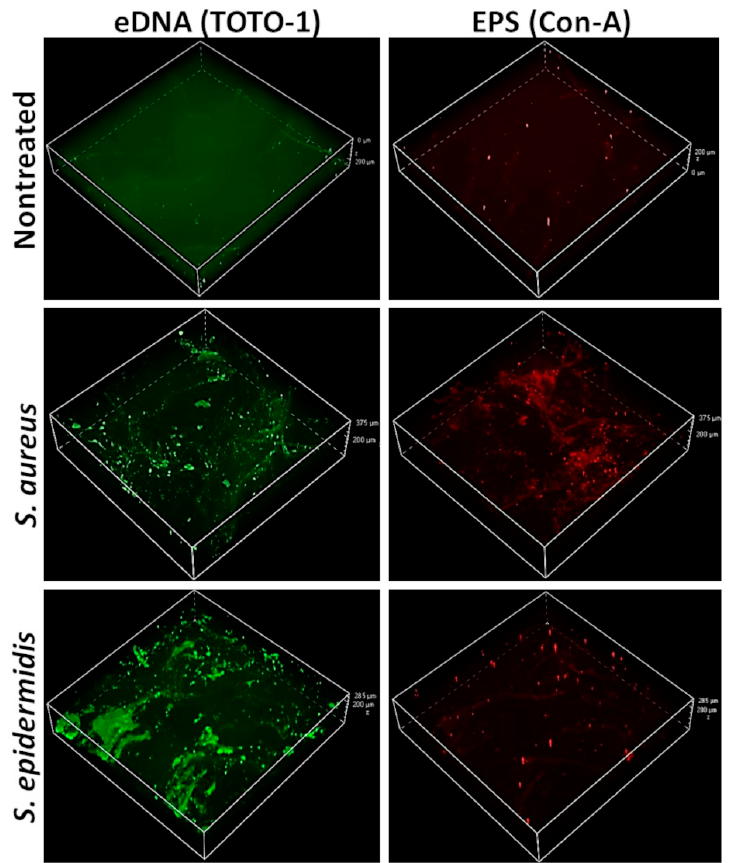
Figure 2. Confocal scanning laser microscopy (CSLM) reconstructed 3D images of ex vivo human skin 24 h post infection with S. aureus and S. epidermidis. Both types of bacteria adhered to the skin’s surface and created an extracellular matrix (ECM), which stained positive for extracellular DNA (eDNA; TOTO-1, green, left panels) and extracellular polysaccharides (EPS; Concanavalin-A, red, right panels). Top panels: nontreated (NT), sterile skin; middle panels: S. - aureus -infected skin; bottom panels: S. - epidermidis -infected skin. Magnification: × 10, the z-axis scale bar is shown for each image.